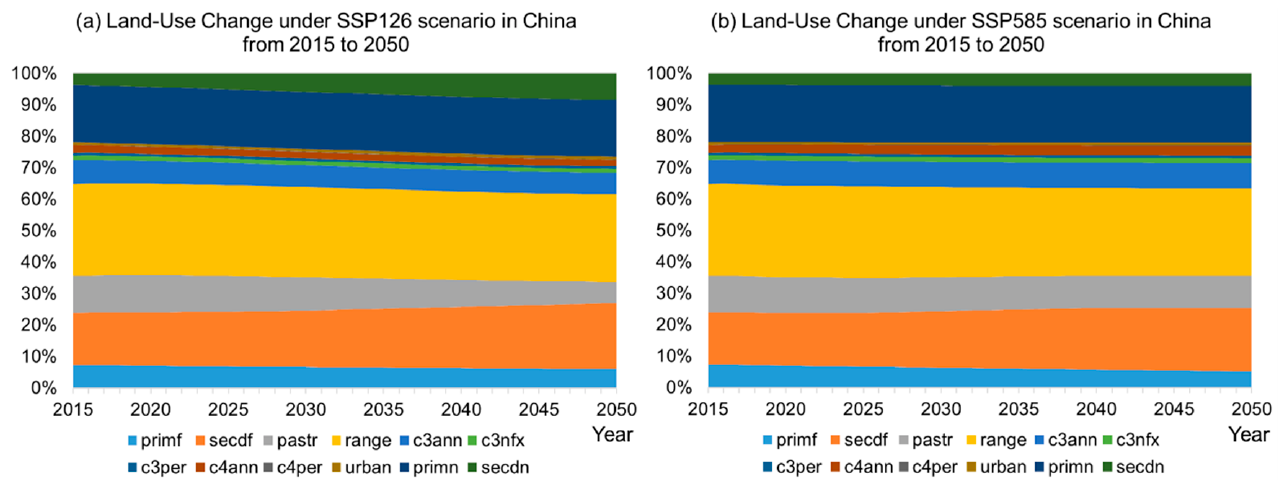
Figure 2. Evolution of land-use types in China from 2015 to 2100 under ( a ) SSP126 and ( b ) SSP585 scenarios (primary forest, secondary forest land, managed pastures, other pastures, C3 annual crops, C3 nitrogen-fixing crops, C3 perennial crops, C4 annual crops, C4 perennial crops, urban, primary non-forest land, and secondary non-forest vegetation land, denoted as primf, secdf, pastr, range, c3ann, c3nfx, c3per, c4ann, c4per, urban, primn, and secdn, respectively).